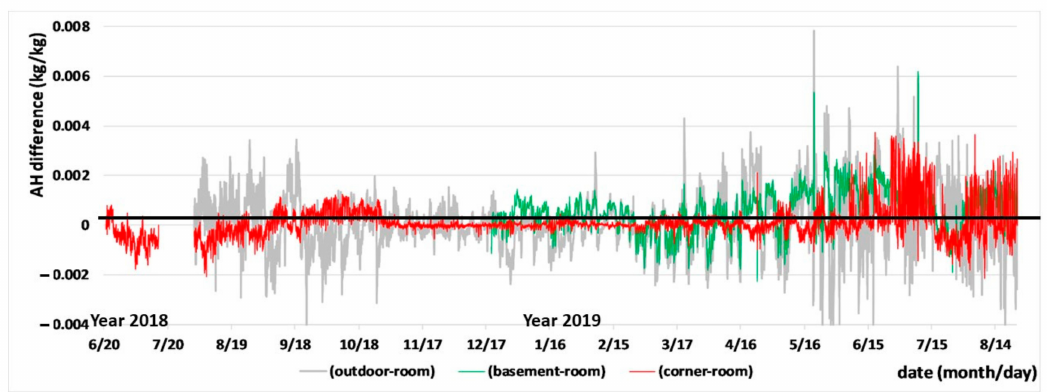
Figure 18. Absolute humidity di ff erences between outdoor, basement, corner and room (at the door).